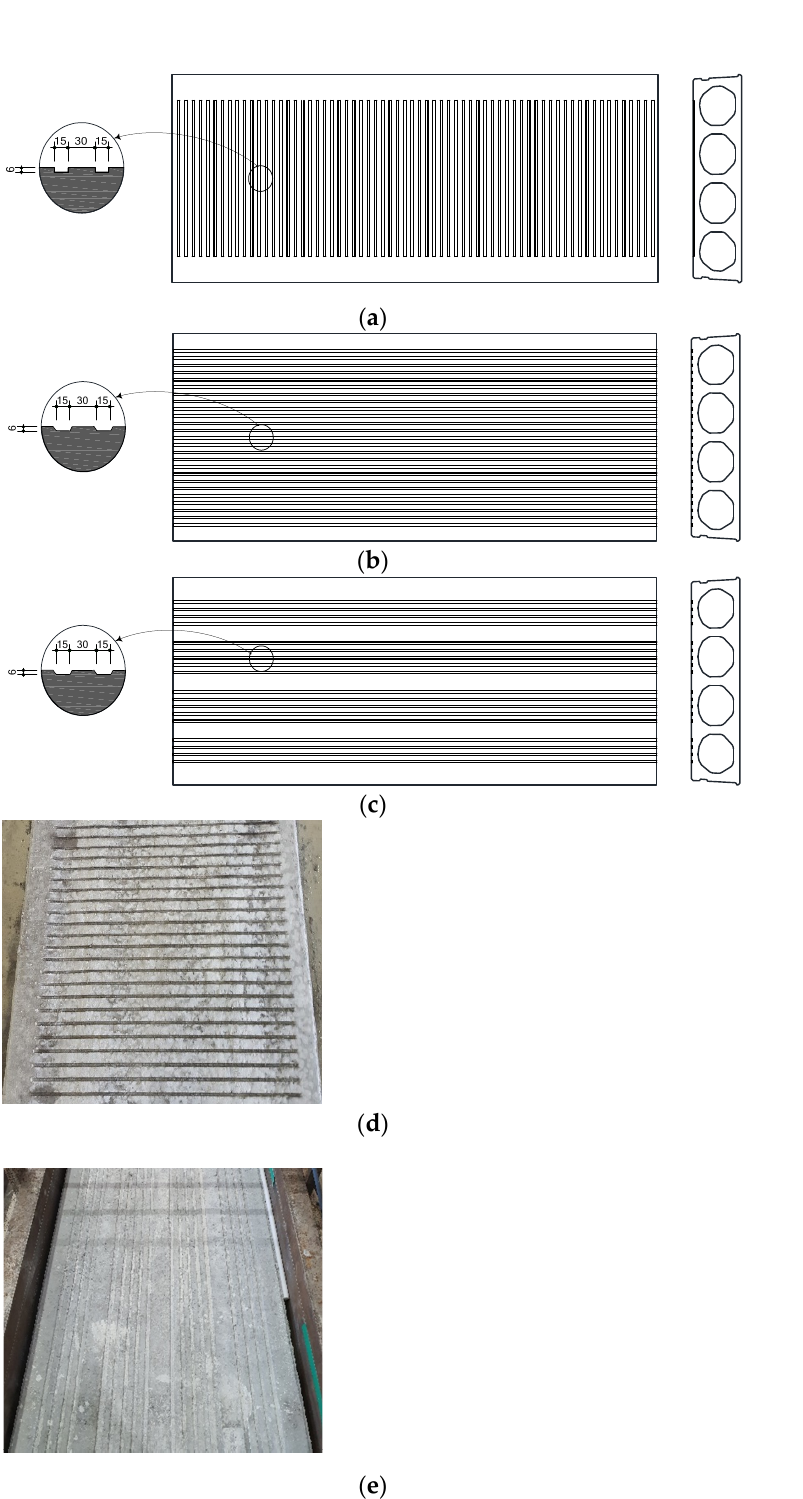
Figure 3. Upper surface of specimens (unit: mm): ( a ) CF series; ( b ) CC series; ( c ) CN series; ( d ) photograph of CF series; ( e ) photograph of CN series.